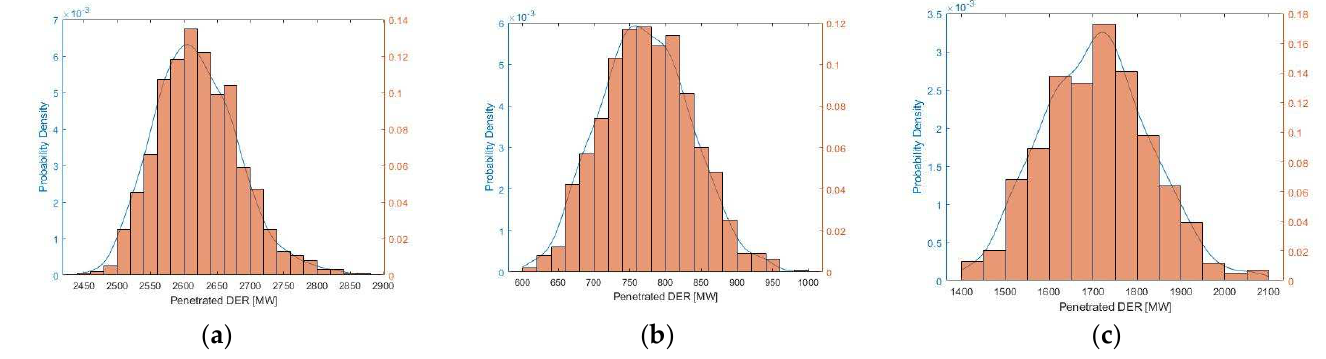
Figure 6. Results of simulations of intensive input in each region: ( a ) Area 1 case; ( b ) Area 2 case; ( c ) Area 3 case.